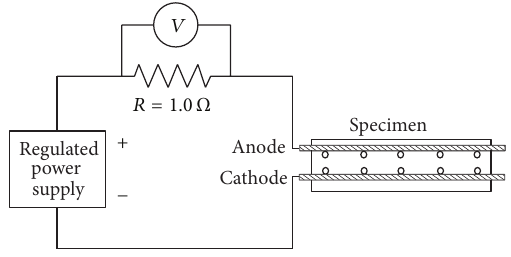
Figure 7: Corrosion cell for laboratory specimens.